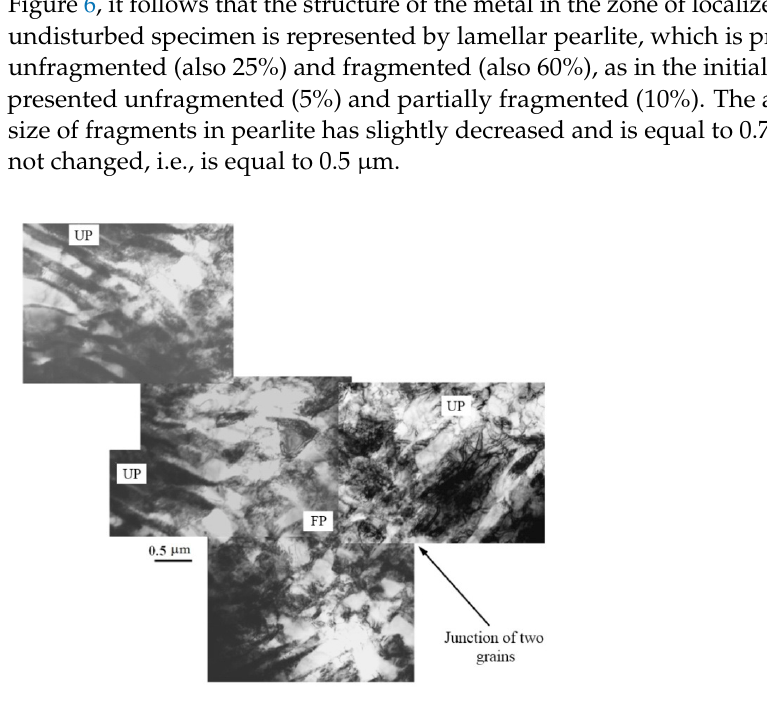
Figure 6. Image of the structure of lamellar pearlite in the zone of localized deformation of an undisturbed specimen of 0.2 С steel (UP—unfragmented, FP—fragmented pearlite). Transmission undisturbed specimen of 0.2 C steel (UP—unfragmented, FP—fragmented pearlite). Transmission electron microscopy. electron